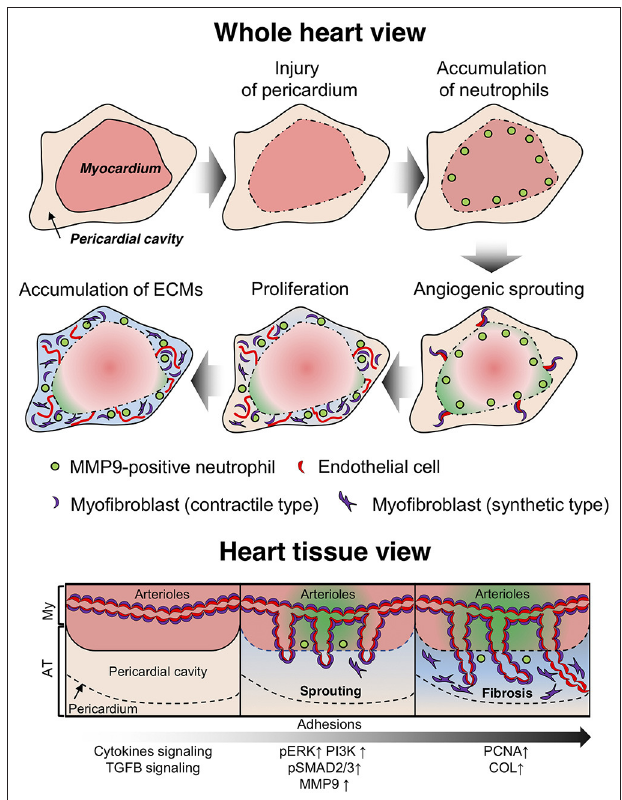
FIGURE 8 | Diagram depicting the molecular mechanism of adhesion formation in the pericardial cavity. After infliction of epicardial injury, several types of immune cells (including neutrophils) accumulate on the surface of heart tissues to enable tissue remodeling via secretion of proteolytic enzymes. Arterioles and capillaries in the heart are excessively sprouted into the pericardial space. Then, smooth muscle cells with a contractile phenotype transition to a hyperproliferative and synthetic phenotype, which potentially contribute to fibrosis via production of extracellular matrix (ECM) proteins. The endothelial cells in the arterioles also exhibit a hyperproliferative phenotype and promote neovascularization in adhesion tissues (whole heart view). Arterial angiogenic sprouting occurs by maintaining vascular coverage with myofibroblasts (heart tissue